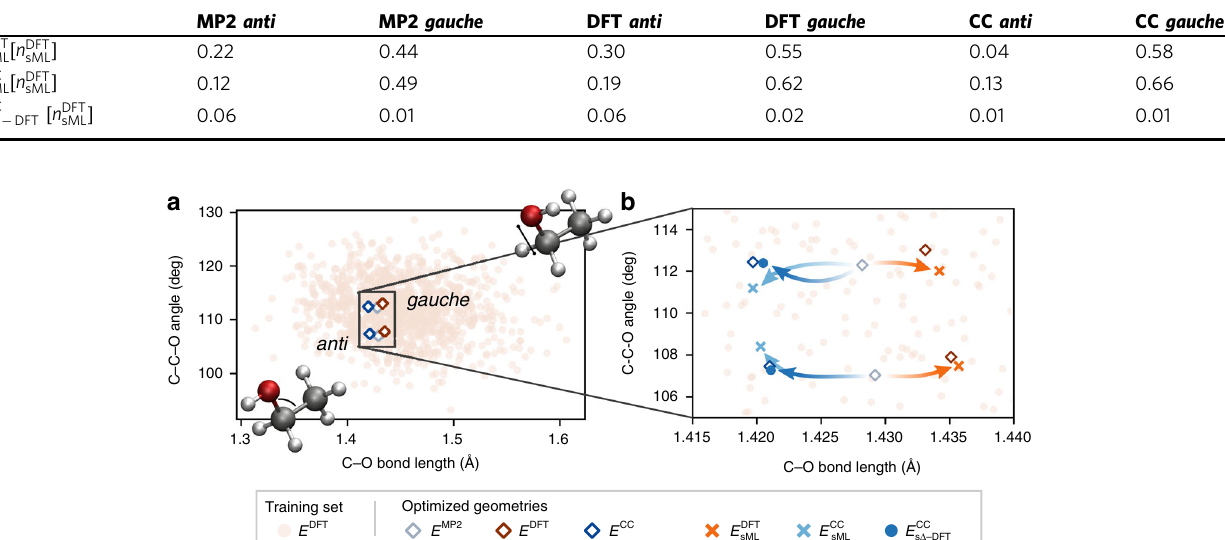
Fig. 2 Molecular geometries of ethanol from the ML training set and optimizations. a 1000 unique con fi gurations used for training (light orange circles), along with the anti and gauche minima optimized using conventional electronic structure methods (open diamonds). The distribution of anti and gauche conformers is shown in Supplementary Fig. 6. b The con fi gurational space near the minima. Starting from MP2 geometries ( E MP2 , grey diamonds), the E ML - based optimizations reproduce the subtle differences in DFT- and CC-optimized geometries (dark orange and dark blue diamonds, respectively). For this fi gure, DFT calculations use the PBE + TS functional and CC calculations use CCSD(T) (see refs. 32,33 for more